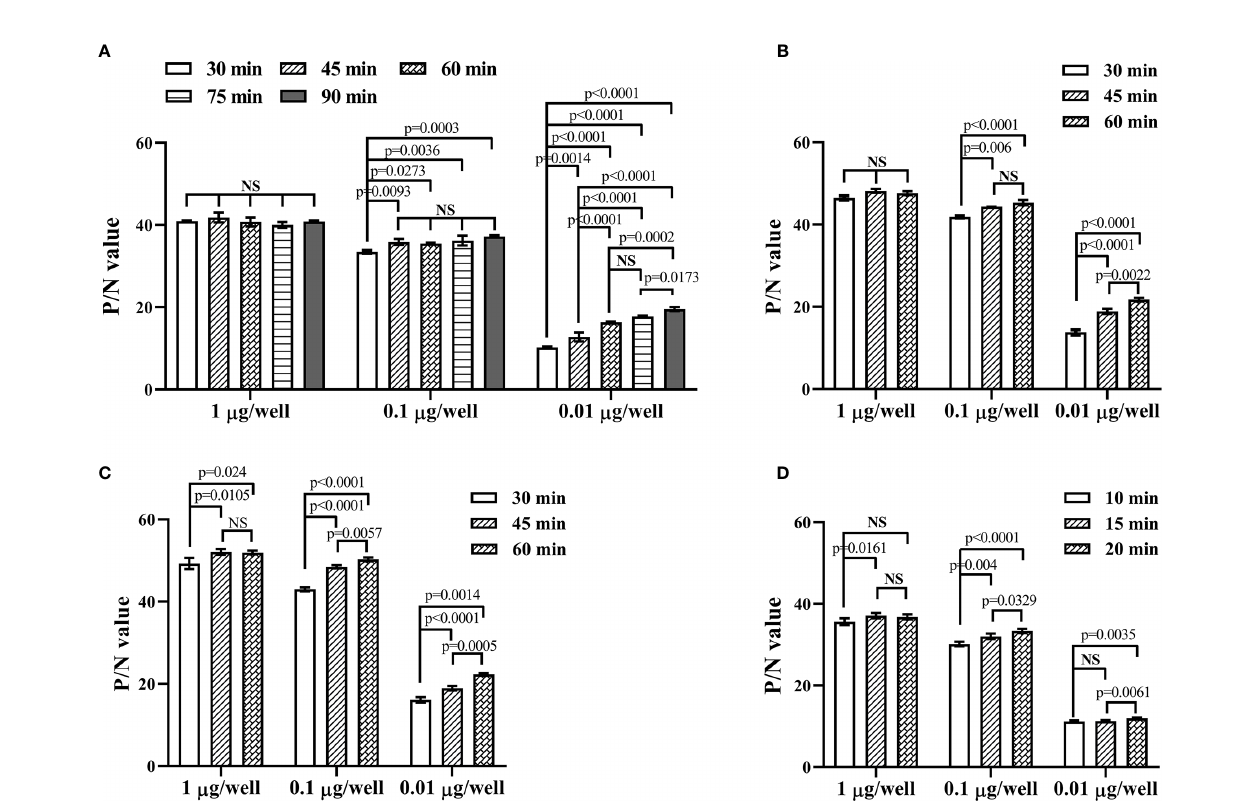
FIGURE 4 | Optimize the reacting conditions of the developed DAS-ELISA. (A) Determination of the incubation time for samples. (B) Determination of the incubation time for the detection antibody. (C) Determination of the incubation time for the HRP-linked goat anti-rabbit IgG. (D) Determination of the colorimetric reaction time. NS, nonsigni fi